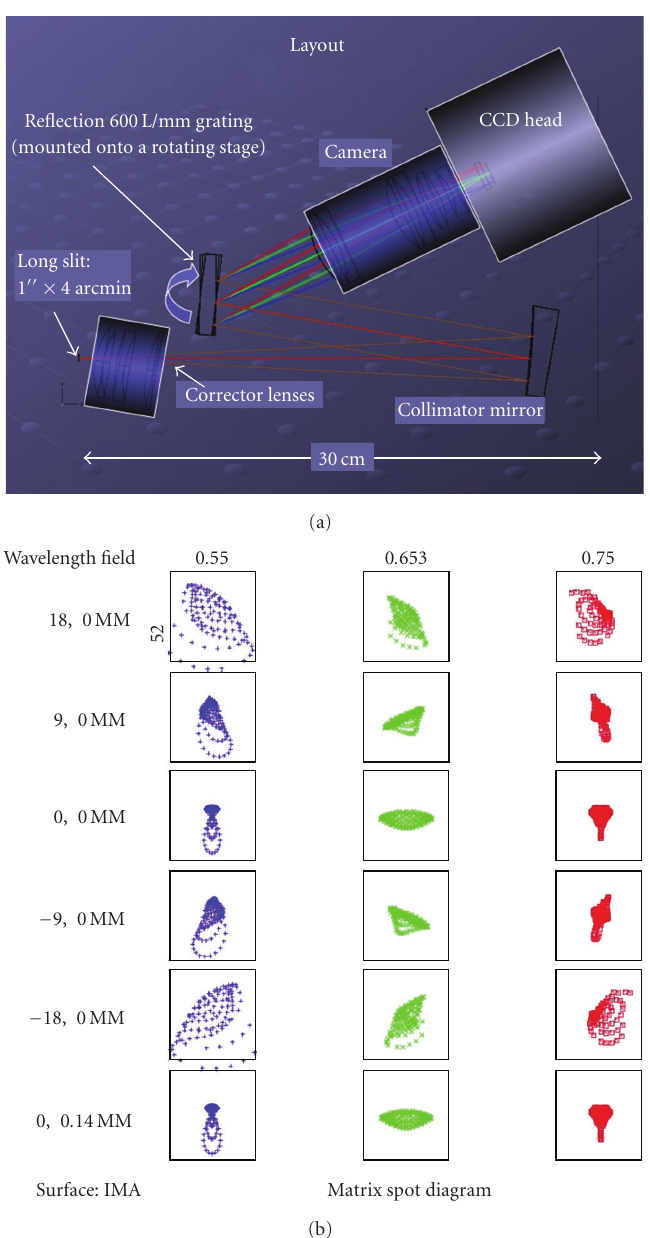
Figure 10: The optical layout of the spectrograph and the relative spot diagram at 550, 653 and 750